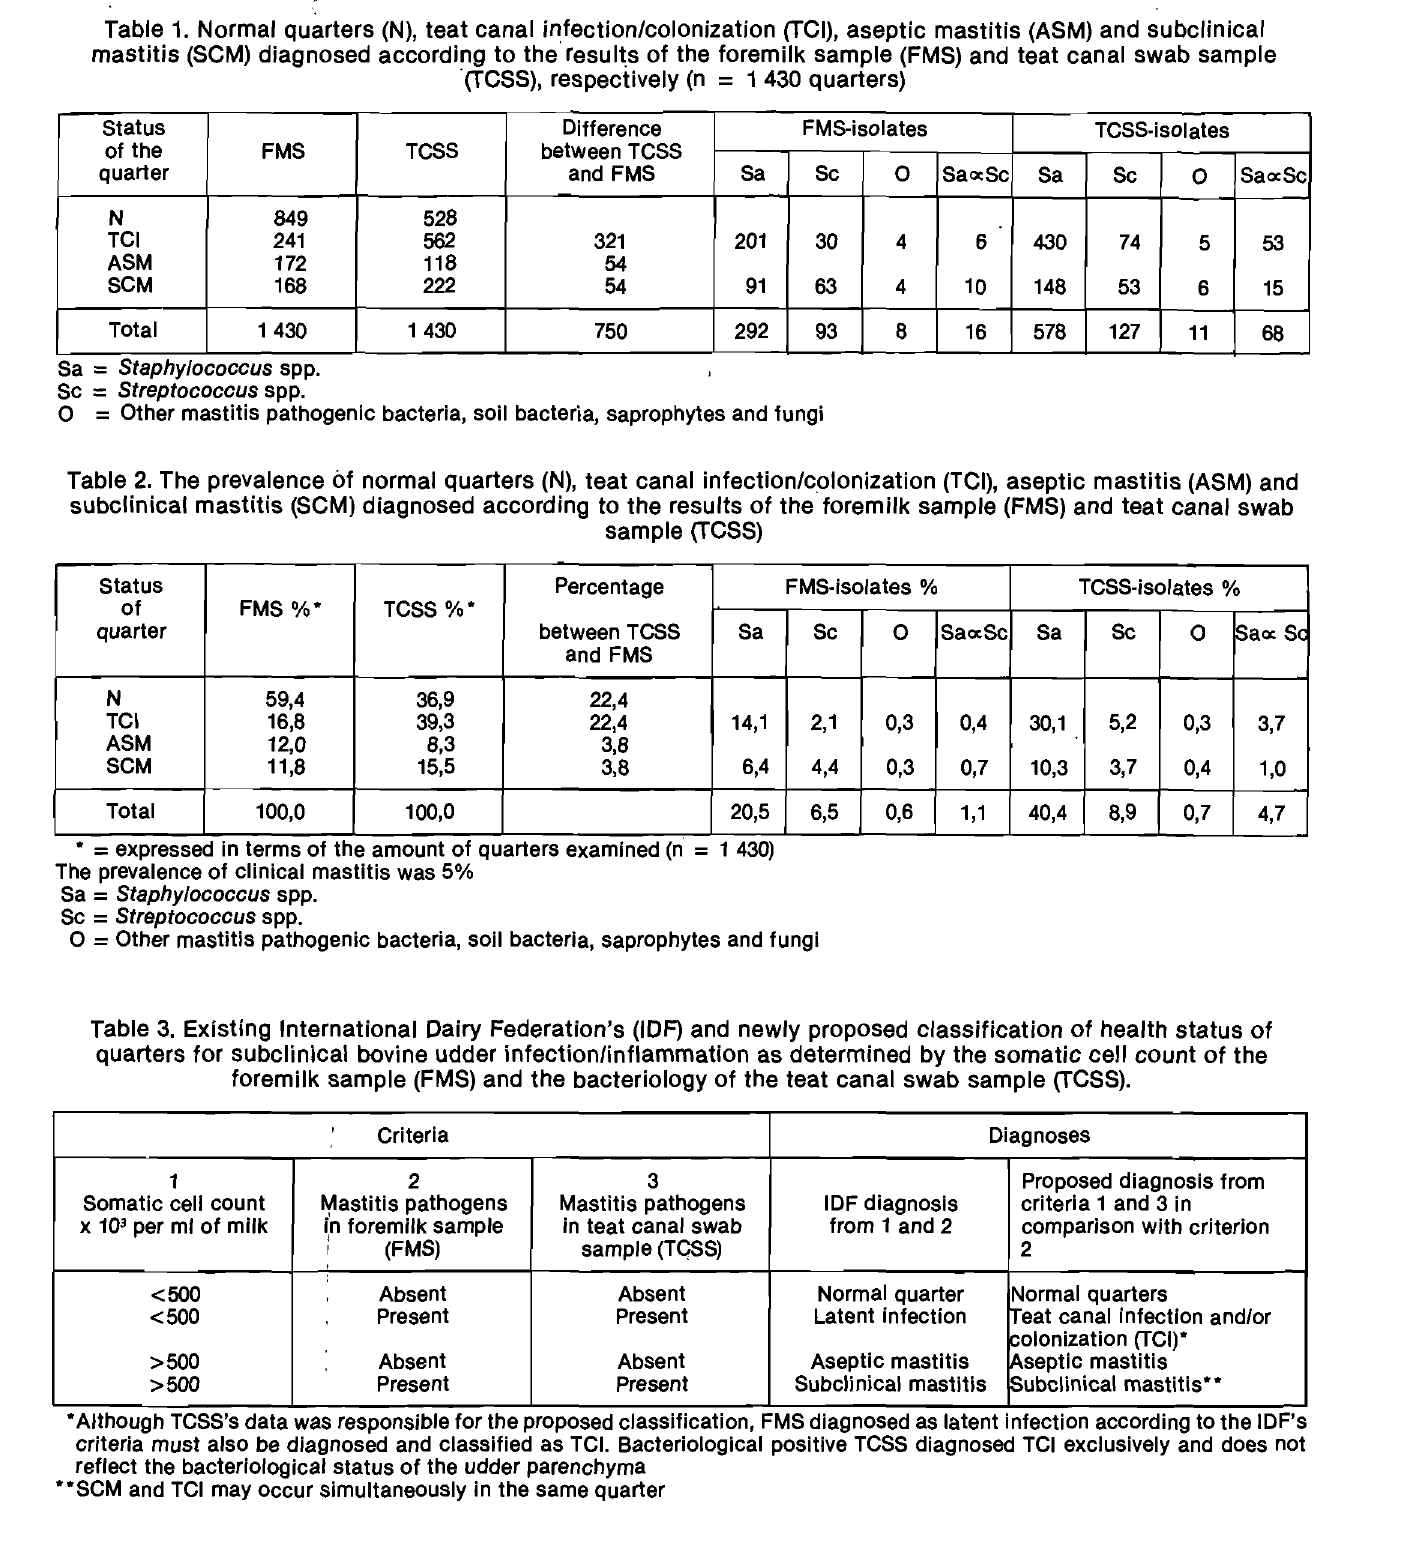
= Staphylococcus spp. Sa = Streptococcus spp. Sc